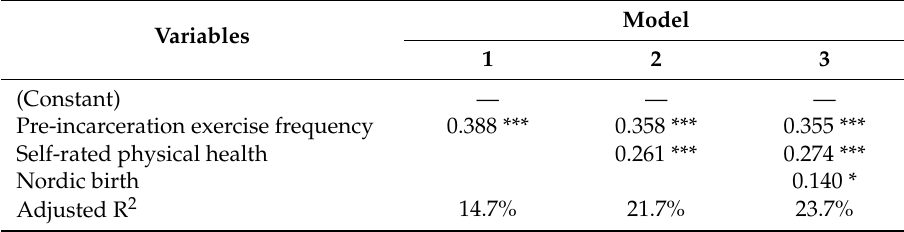
Table 3. Adjusted models explaining variance in exercise frequency during incarceration of inmates with no harmful substance use ( n =